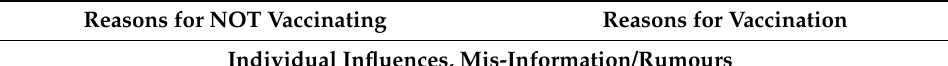
Table 13. Description of theme individual influences—misinformation/rumor with verbatim.